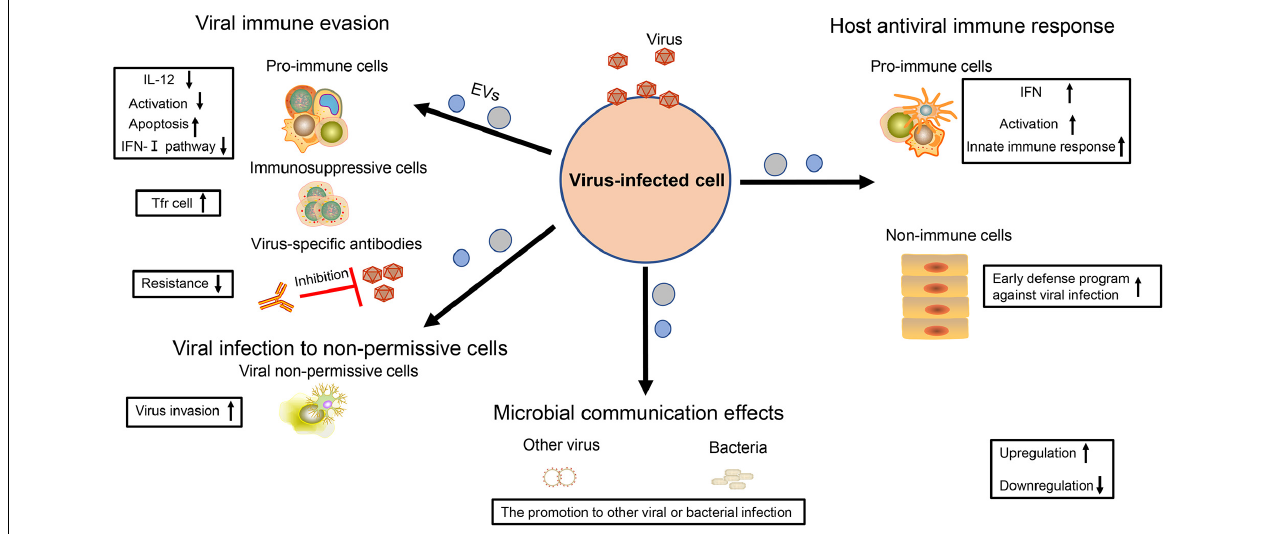
FIGURE 2 | The multiple effects of virus-regulated EVs. The EVs derived from virus-infected cells are endowed with various functions. For virus, these EVs not only contribute to viral immune evasion but also help viruses to infect non-permissive cells. For the host cell, these EVs are also the powerful weapons to achieve antiviral immunity. In addition, the EVs also have an influence on other viral or bacterial infections, thereby contributing to microbial